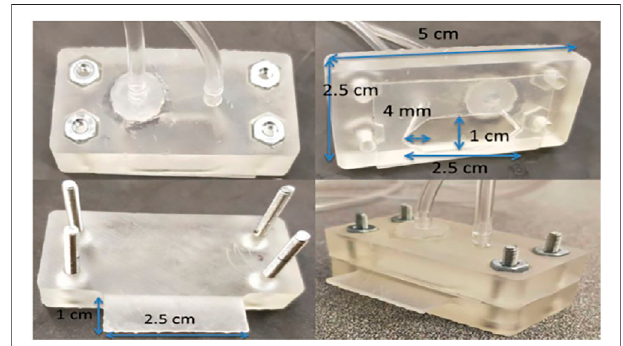
FIGURE 6 | Optical images of the fl ow cell.